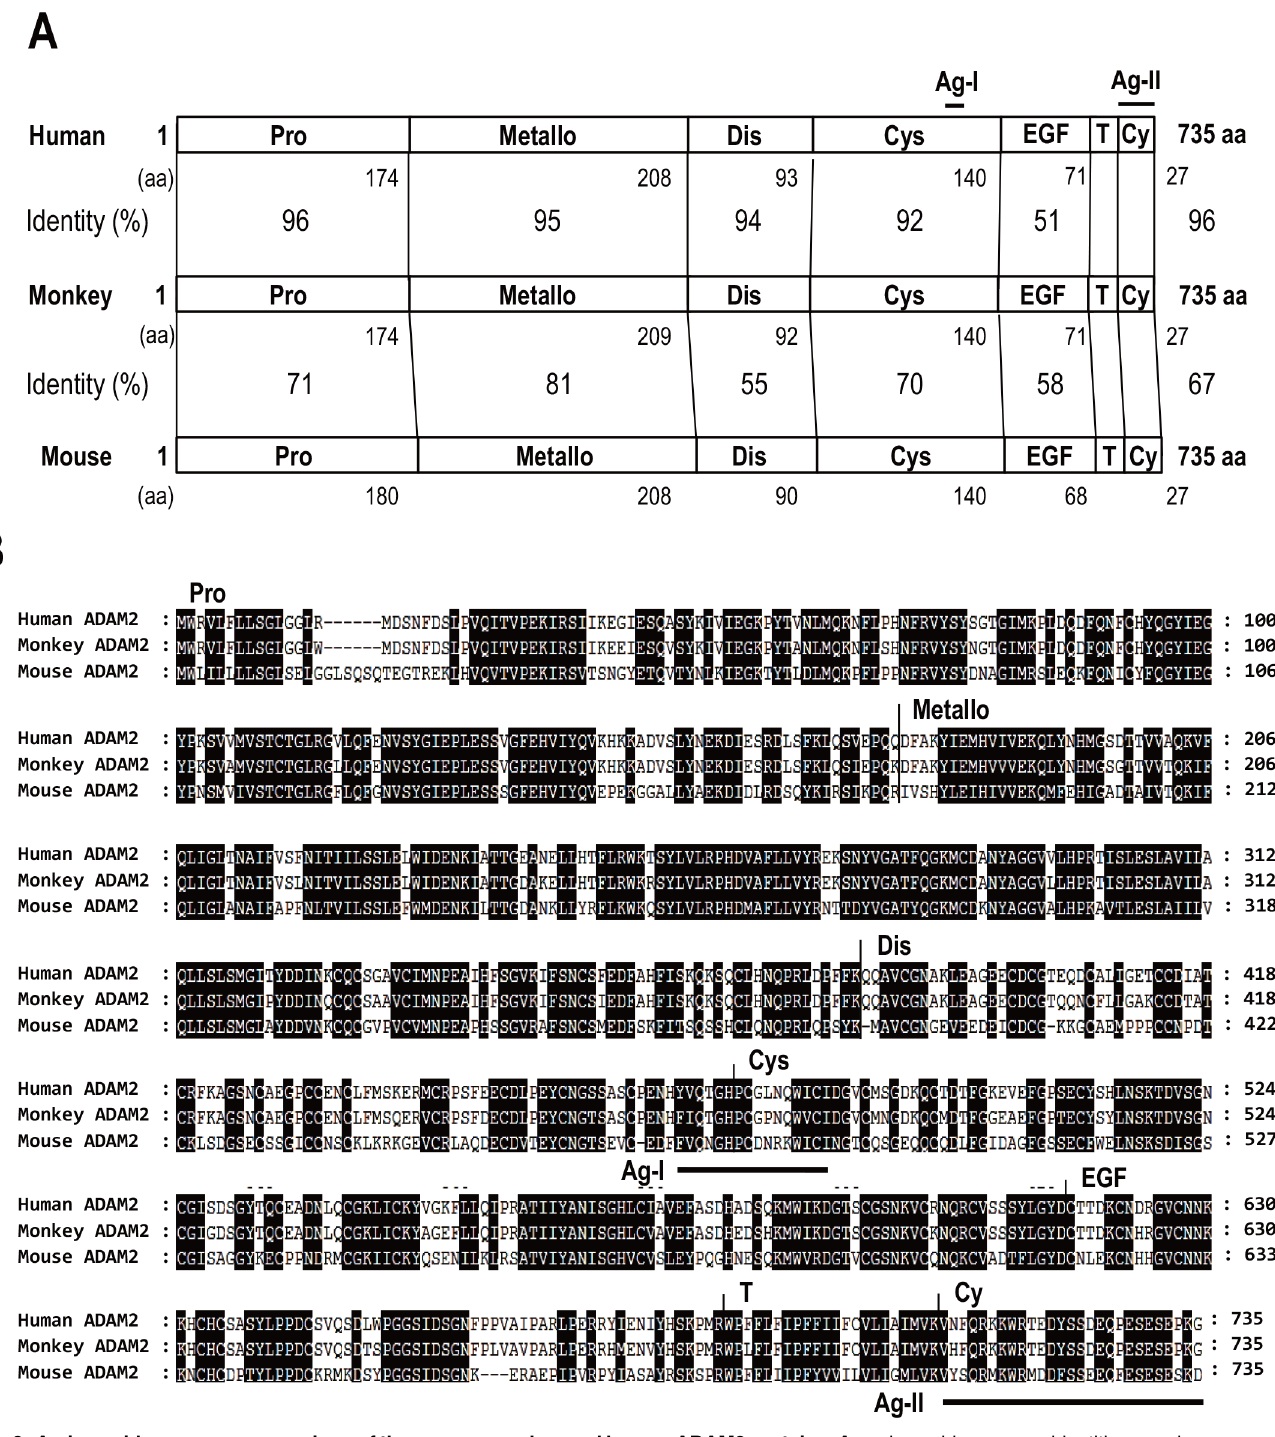
PLOS ONE | DOI:10.1371/journal.pone.0158321 June 24,